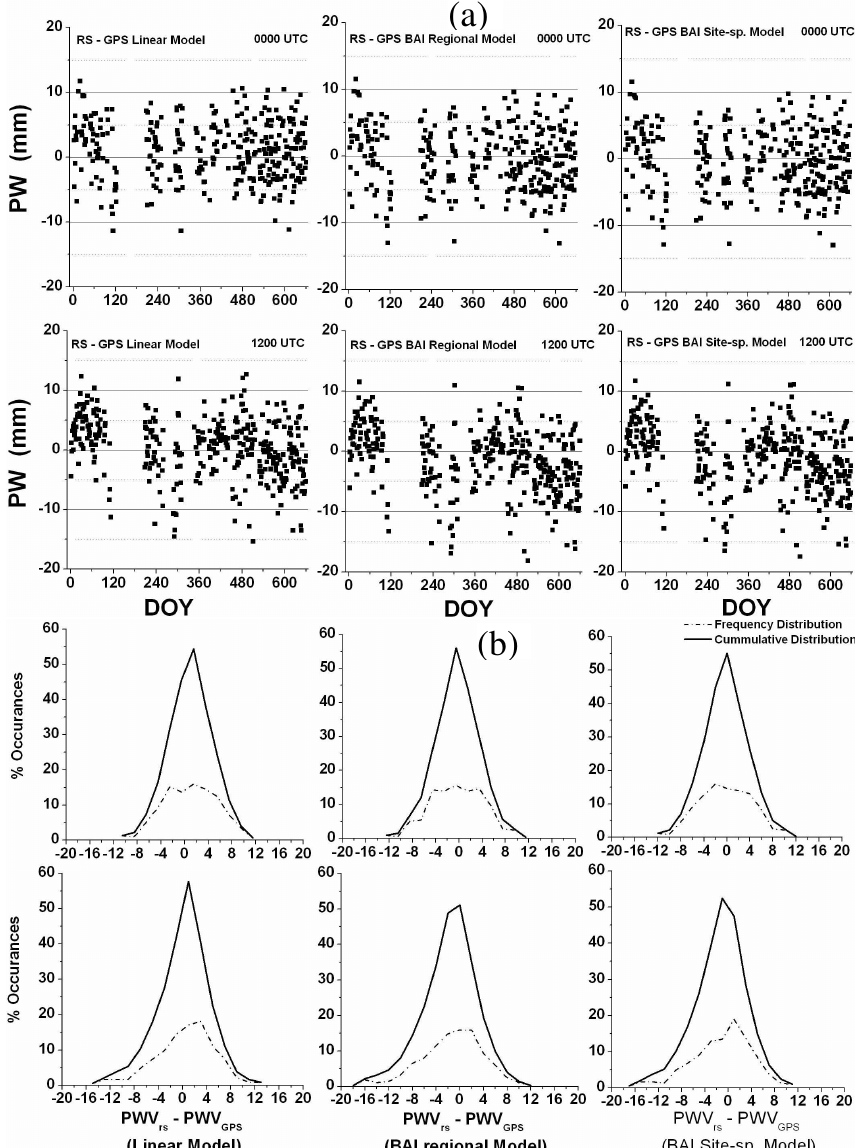
Fig. 8. Difference between Radiosonde derived PW and GPS derived PW for 00:00 UTC and 12:00 UTC for Bangalore. The left-hand side panels show the deviation of PW GPS estimated employing the linear model from radiosonde derived values, while the middle and right-hand side panels show the same for BAI regional model and BAI site-specific model (a) . Percentage distribution and cumulative percentage (number of occurrences above a particular value in the case of positive deviations and number of occurrences below a particular value in the case of negative deviations) distribution of the deviations shown on different panels of Fig. 9a (b)